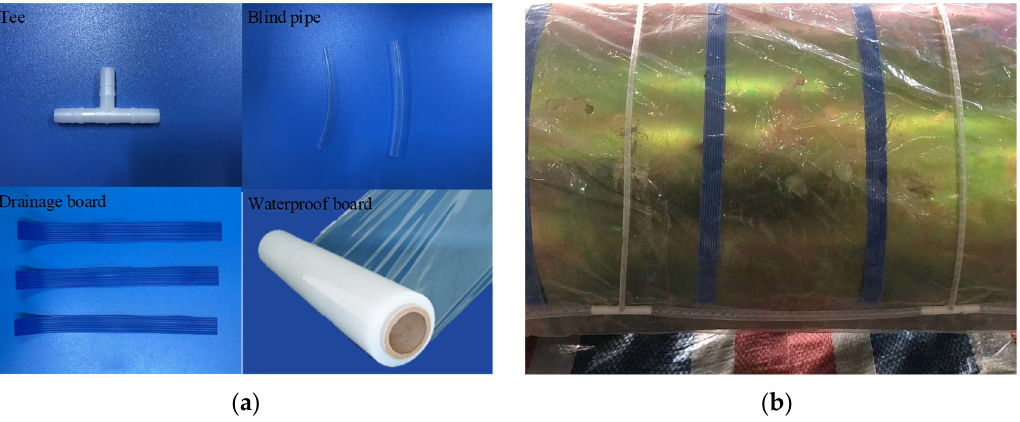
Figure 5. Components of drainage system. ( a ) drainage board; ( b ) assembly.